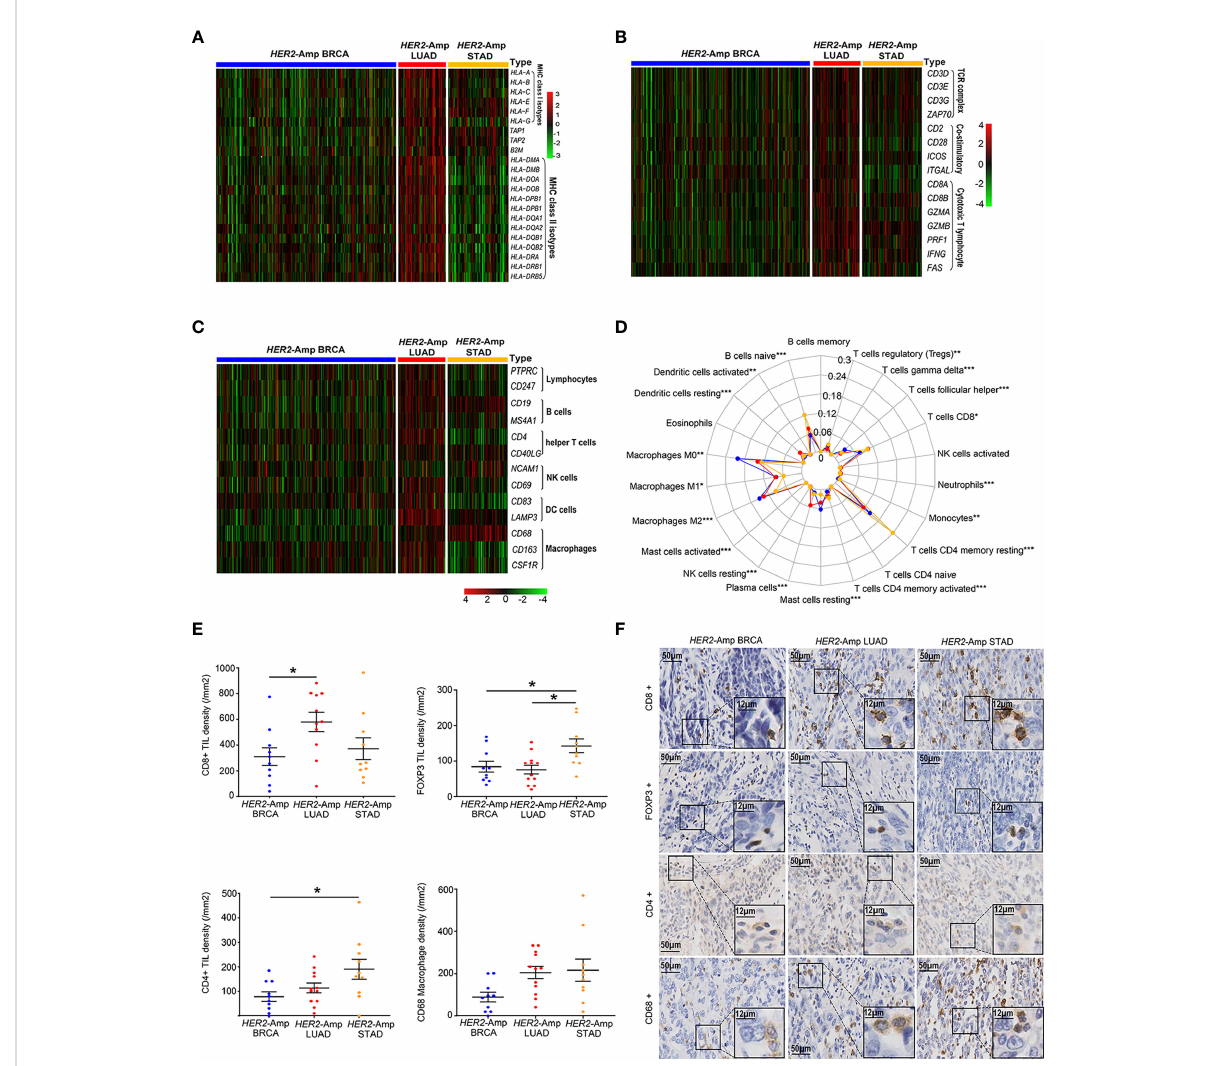
FIGURE 3 The landscape of the TIME among HER2 -ampli fi ed BRAC, LUAD and STAD. (A) Heatmap depicting the expression of HLA-related gene pro fi les among three distinct tumors from RNA-seq. (B) Heatmap depicting the process of T cell activation, including antigen recognition, signal transduction and T cell immune ef fi cacy from RNA-seq data. (C) Heatmap depicting the mRNA expression levels of the immune cell-associated gene signature. (D) A radar chart displaying the fraction of in fi ltrated immune cells by CIBERSORT. The blue, red and yellow lines represent HER2 -ampli fi ed BRAC, LUAD and STAD, respectively. (E) Comparison of TIL and macrophage densities at intratumoral regions among patients with HER2 -ampli fi ed LUAD (n=12), HER2 -ampli fi ed BRCA (n=10) and HER2 -ampli fi ed STAD (n=10). Note: The paraf fi n section of 1 patient with HER2 -ampli fi ed LUAD failed the quality control after CD8 IHC staining and was not included in the statistical analysis. (F) Representative images of HE staining and IHC staining of HER2, CD4, CD8, FOXP3 and CD68 among the above-mentioned tumors. P < 0.05 was regarded as signi fi cantly different. *** P < 0.001, ** P < 0.01, * P <